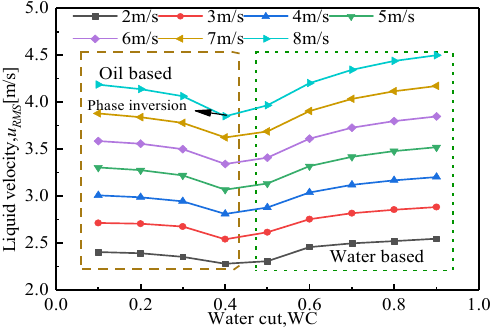
Figure 7. u RSM variation with WC at J L = 1.5 m/s, J g = 2.0–8.0 m/s. Figure 8 shows the internal liquid fluid mass per unit length ( m RMS ) varying with WC for J L = 1.5 m/s and J g = 2.0–8.0 m/s. As can be seen from Figure 8a, m RMS increases as WC increases at each superficial gas velocity, due primarily to both the liquid holdup and mixture density increasing with the increase in WC. Furthermore, it is worth noting that the difference between the values of m RSM of different WC decreases as J g increases.